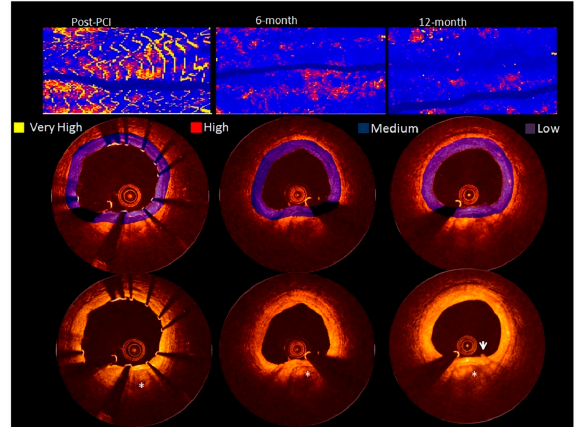
Figure 2. Optical coherence tomography of DREAMS 2G. At the top, 3 spread out panels showing the attenuation maximum values. Post-PCI, the attenuation values that correspond to the scaffold struts are very high (yellow). The scaffold design can be recognized. Those very high values subsided over time, corresponding to the bioresorption process of the struts. In the middle row, 3 OCT frames are depicted. Post-PCI, the struts are shown with very high attenuation values, which disappeared over time. At the bottom, post-PCI struts are bright structures with shadowing behind. In the corresponding frames at 6 and 12 months (please note the calcium marked by *), a remnant of struts is present at 5 o’ clock (arrow), (Reproduced from: Garcia-Garcia HM et al. Int. J. Cardiol. 2018 Mar 15, 255, 22–28.) [13].